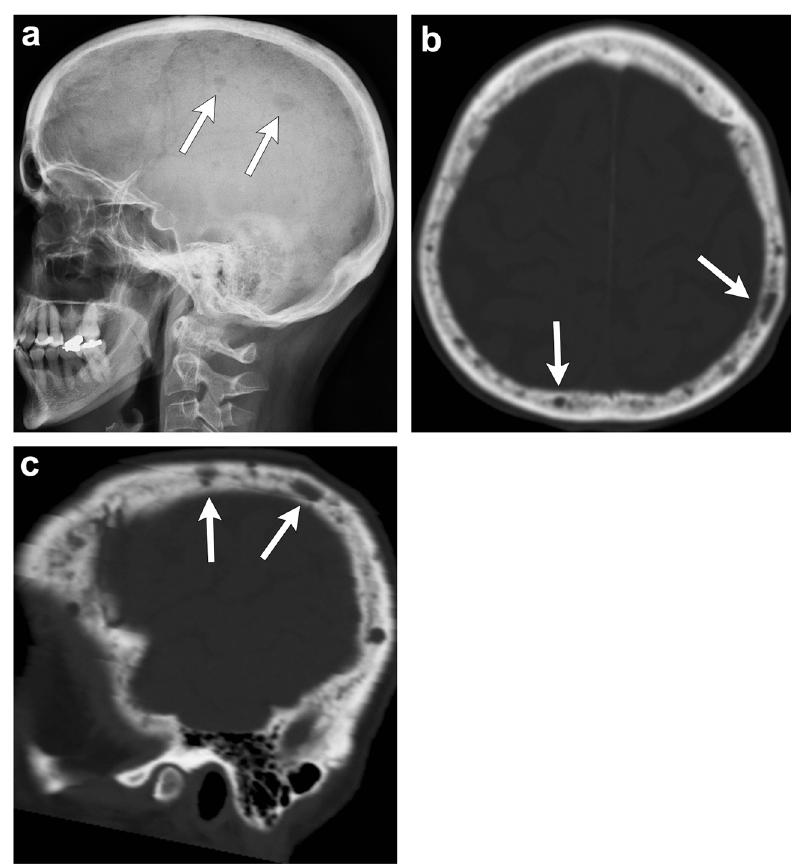
Fig. 16 Multiple myeloma.